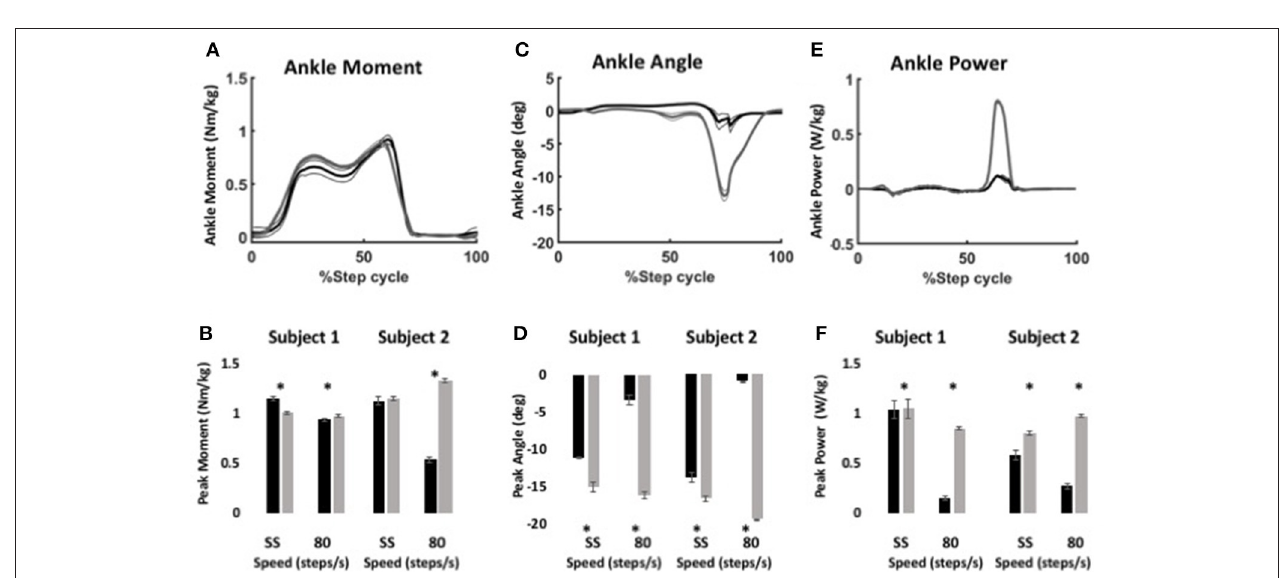
FIGURE 6 | Ankle kinematics and kinetics during stair ascent using WFH (gray) and BiOM stock (black) controllers. (A) Average ankle moment (Nm/kg) ± SEM vs. % step cycle. (B) Peak ankle moment (Nm/kg) ± SEM for two subjects ascending stairs at self-selected speed and 80 steps/min. (C) Average plantarflexion angle (degrees) ± SEM vs. % step cycle. (D) Peak plantarflexion angle (degrees) ± SEM for two subjects ascending stairs at self-selected speed and 80 steps/min. (E) Average ankle power (W/kg) ± SEM vs. % gait cycle. (F) Peak ankle power (W/kg) ± SEM for two subjects ascending stairs at self-selected speed and 80 steps/min. Data in (A,C,E) from Subject 2 ascending stairs at 80 steps/min. Asterisks (*) represent statistical differences ( P < 0.05) using Steel-Dwass non-parametric tests.